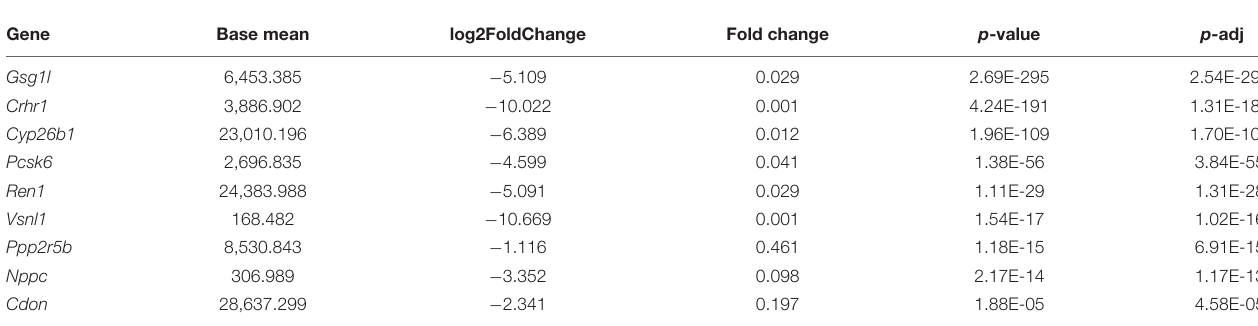
TABLE 1 | Fetal Leydig cells (FLC) specific